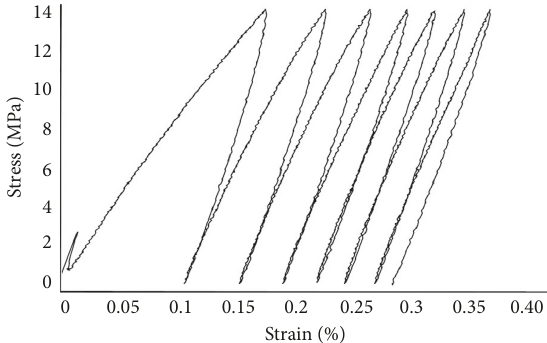
Figure 7: Stress–strain response of ZRJ-S1-reinforced cement- based